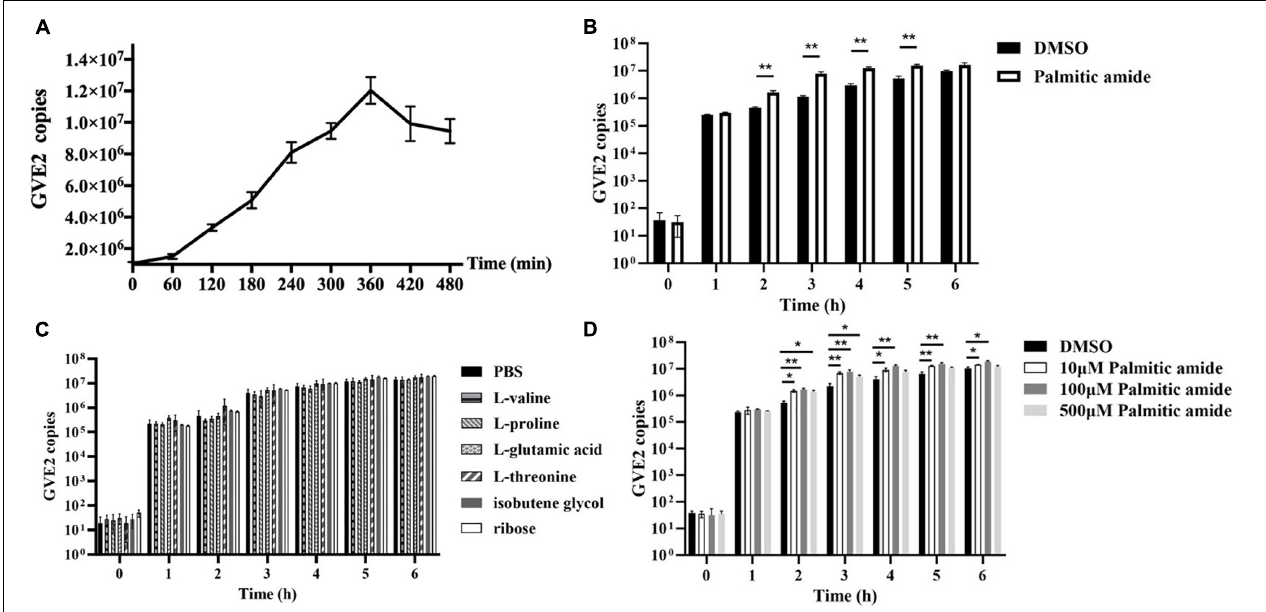
FIGURE 2 | Roles of metabolites packaged in viral particles on phage replication. (A) One-step growth curve of GVE2 in its host Geobacillus sp. E263. (B) Influence of palmitic amide on GVE2 replication. The GVE2-infected Geobacillus sp. E263 was incubated with palmitic amide which was dissolved in DMSO. DMSO alone was used as a control. At different time post-infection, the GVE2 copy was measured by quantitative real-time PCR. (C) Effects of valine, proline, glutamic acid, threonine, ribose and isobutene glycol on phage replication. The GVE2-infected Geobacillus sp. E263 was added with valine, proline, glutamic acid, threonine, ribose or isobutene glycol dissolved in PBS. PBS alone was used as a control. At different time post-infection, the GVE2 copy was examined. (D) Influence of palmitic amide at different concentrations on GVE2 replication. The GVE2-infected Geobacillus sp. E263 was added with palmitic amide at 10, 100, or 500 µ M, followed by the detection of GVE2 copies with quantitative real-time PCR. DMSO was used as a control. In all panels, the statistical significance between treatments were indicated with asterisks (* p < 0.05; ** p <